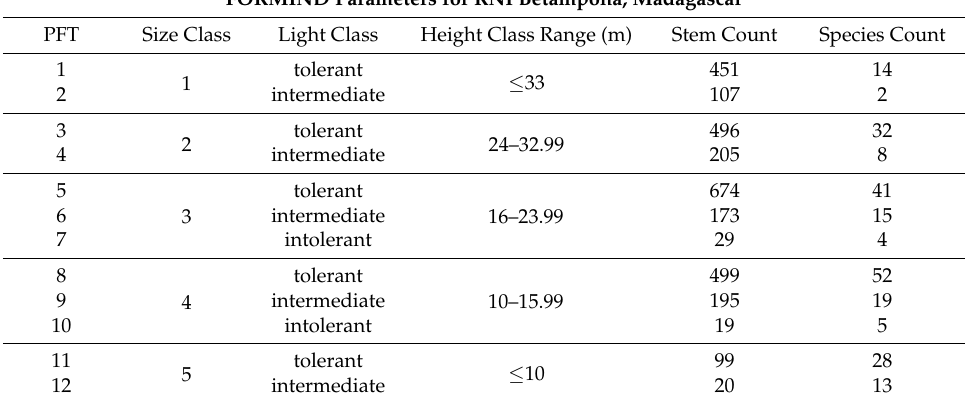
Table 1. Derived grouping of tree species (in total 12 groups) and stem- and species-count calculated from 2004 and 2005 inventory plot data.